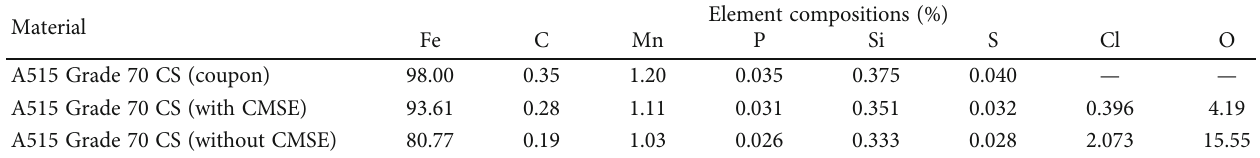
Table 12: Chemical composition of A515 Grade 70 CS with and without CMSE.